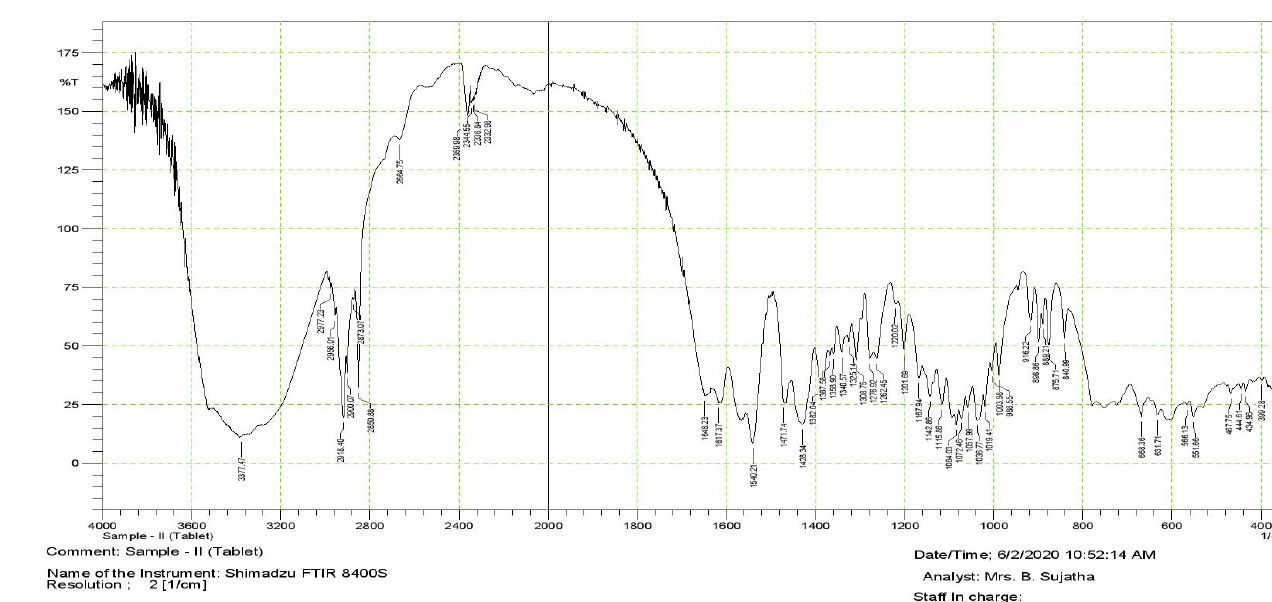
FIGURE 10 - Fourier-transform infrared spectrum of calcium oxalate